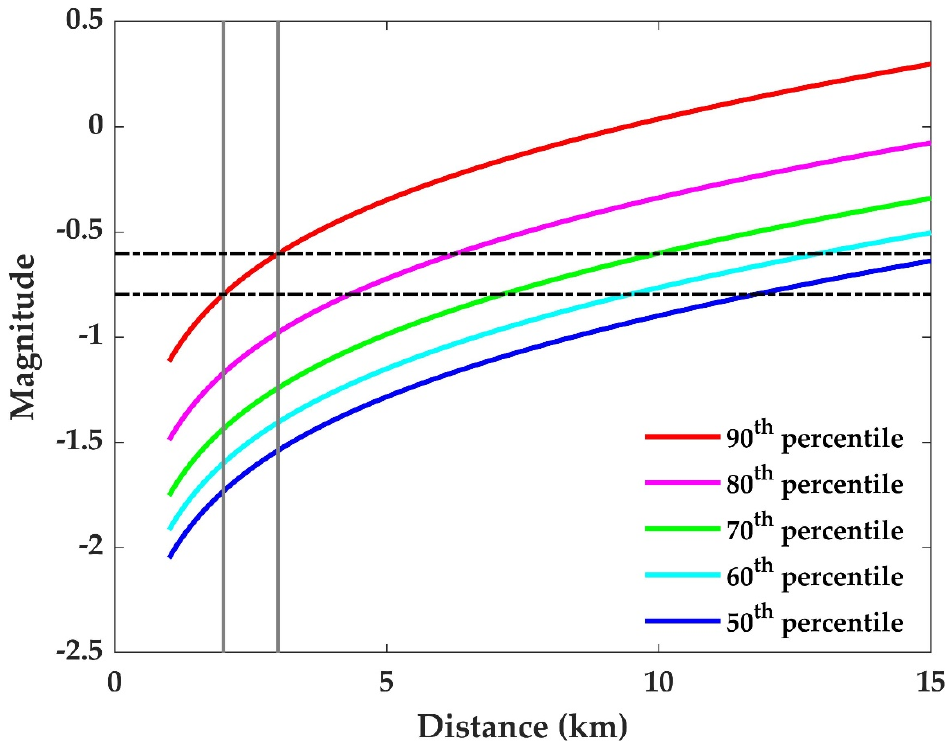
Figure 6. Attenuation curves computed through the application of equation The coloured solid lines represent the different percentiles of the noise distribution as reported in the legend. The grey solid lines mark the reference distance range between 2 and 3 km, while the dashed-dotted black lines represent the average limit magnitude at those distances for the 90th percentile curve.